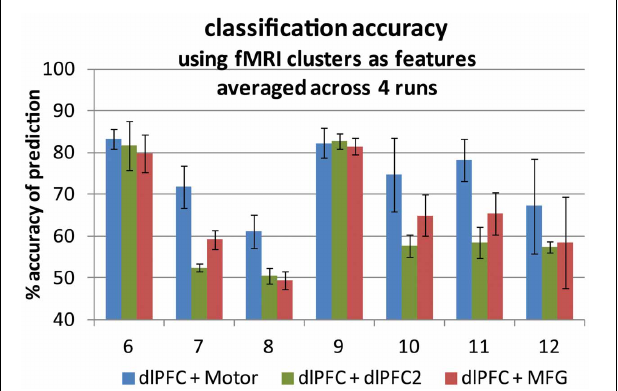
FIGURE 4 | Classification accuracy averaged across four runs for each of seven participants. Two fMRI time traces were used as support vector machine input features in each case. Accuracy is the number of time points for which the prediction matched the truth label out of all 200 volumes. An accuracy of 50% represents prediction by chance. Error bars represent ± one standard deviation. Left-hand bars : co-activating pairs (blue). Center bars : within-network pairs (green). Right-hand bars : cross-region pairs